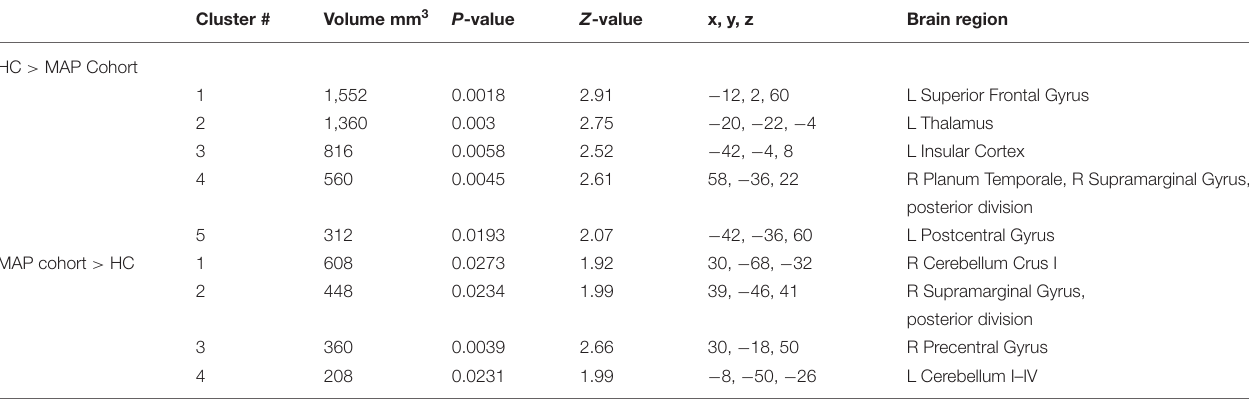
TABLE 8 | Activated brain regions within each between-group contrast for MAP cohort performing a movement execution